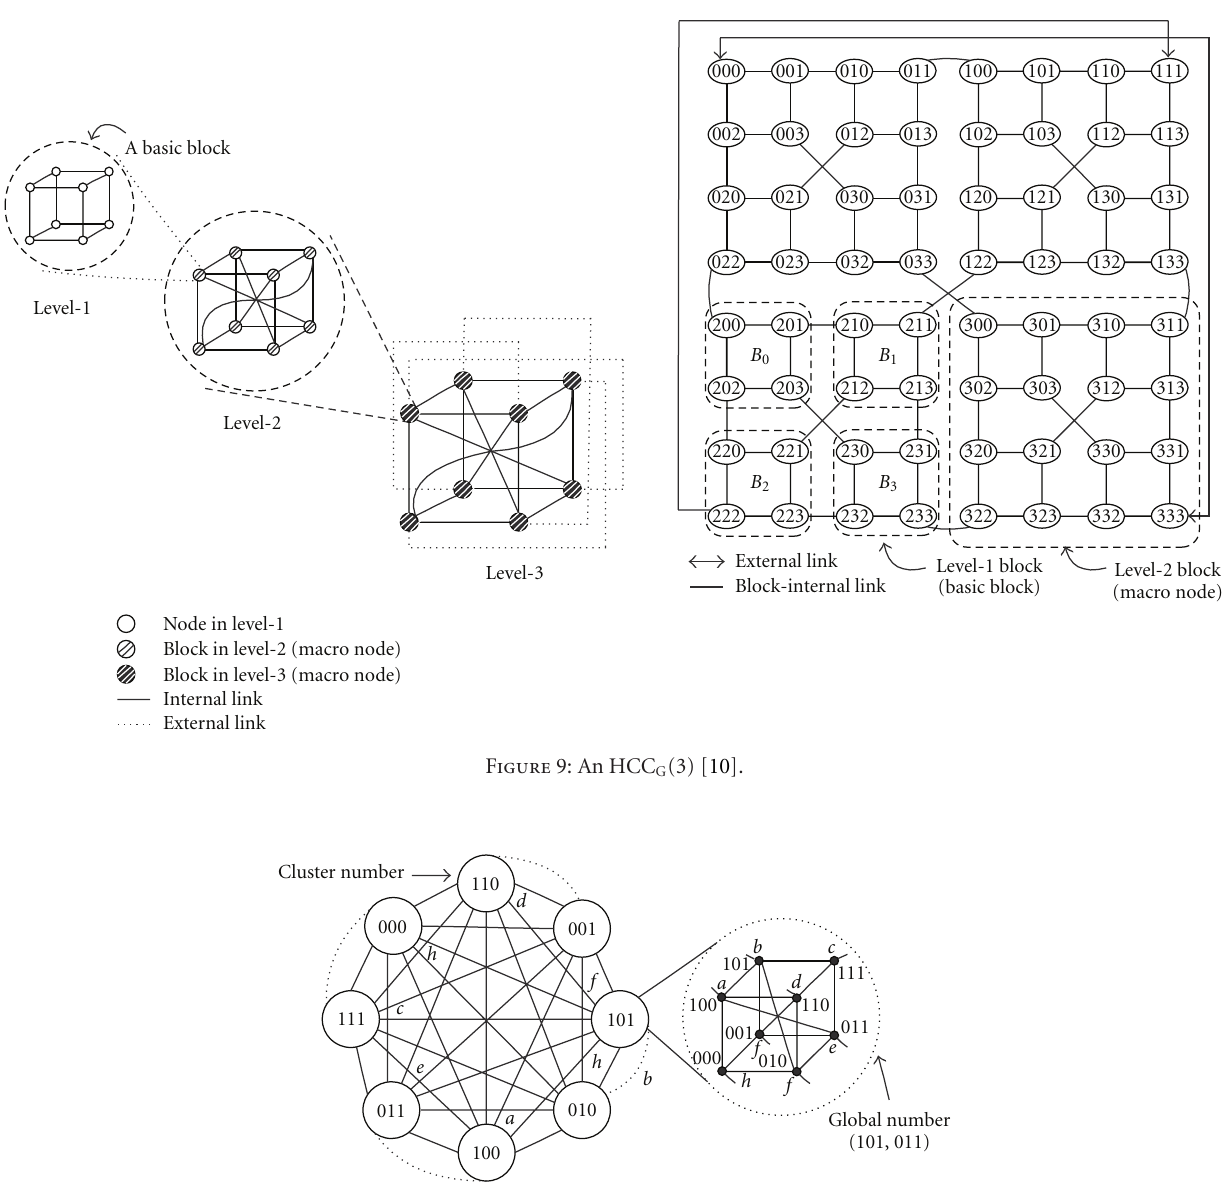
Figure 10: An HFCube(3,3) network